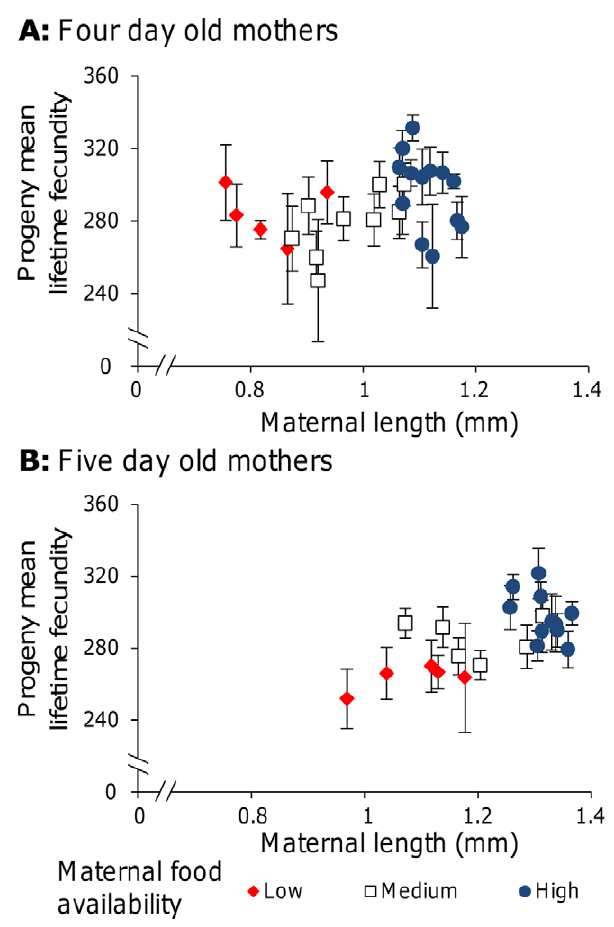
Figure 2. Maternal size does not explain variation in progeny reproduction. The mean lifetime fecundity of the progeny of individual four (A) and five (B) day old parents that developed at High food (20% w/v in both cases), where excess food remained, Low food (1.25% and 2.5% w/v for four and five day old worms, respectively), where food had been depleted, and Medium food (2.5% and 5% w/v for four and five day old worms, respectively), where small quantities of food remained. Note that food concentrations differed between age groups due to the differing times that worms had been maintained on the plates. Mean fecundities were calculated from 4–10 progeny/parent (median 8).